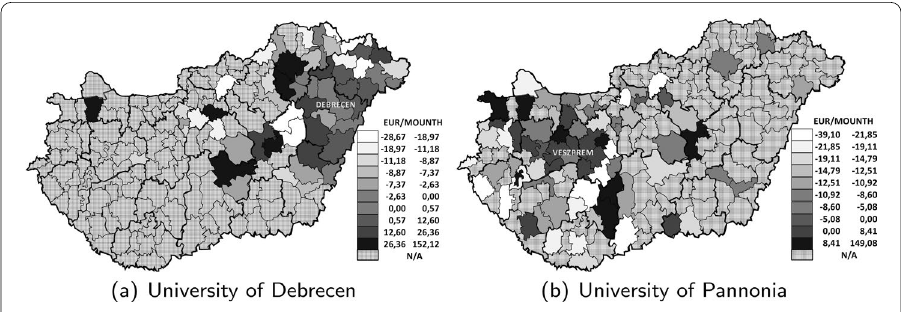
Fig. 6 Added value of the HEIs to salaries (10 deciles) in business &